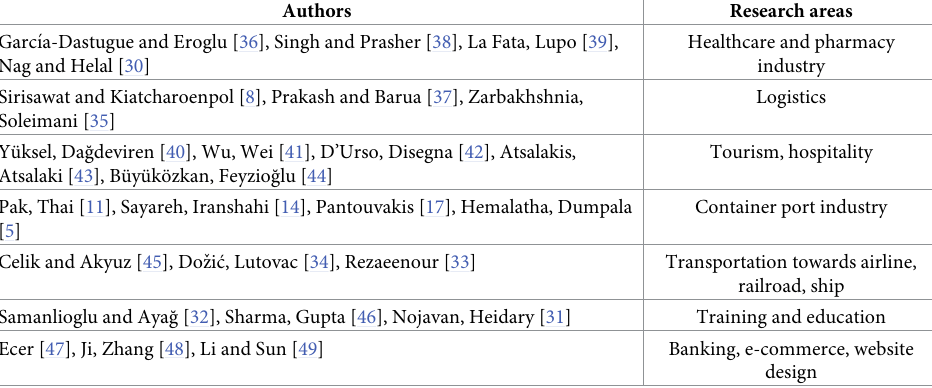
Table 1. The prior studies use the theory of the